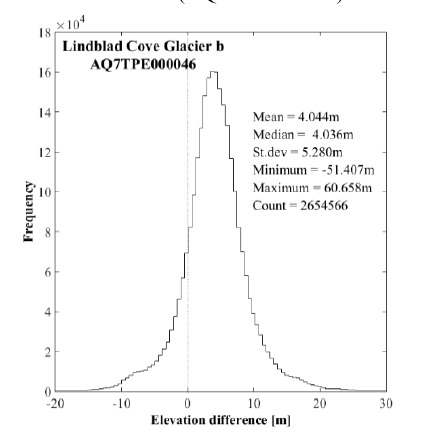
Figure 8. Histogram of elevation differences between archival 1957 and modern 2014 DEMs for Lindblad Cove Glacier ‘ a ’ (AQ7TPE000045).